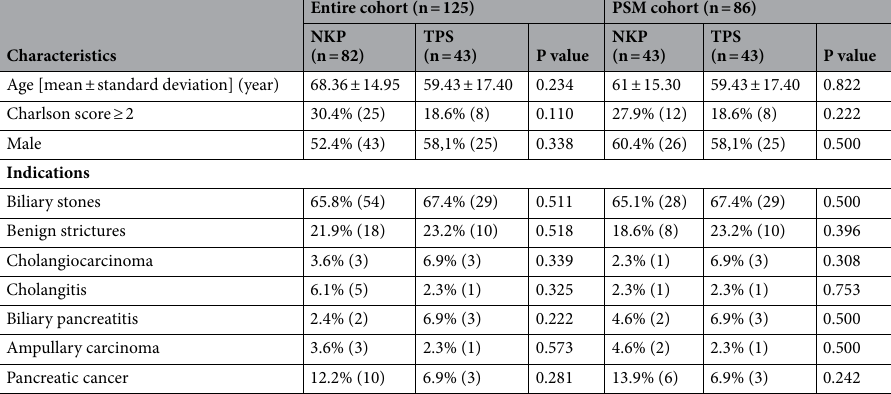
Table 1. Characteristics’ summary and indications for ERCP in the total cohort and PSM-matched